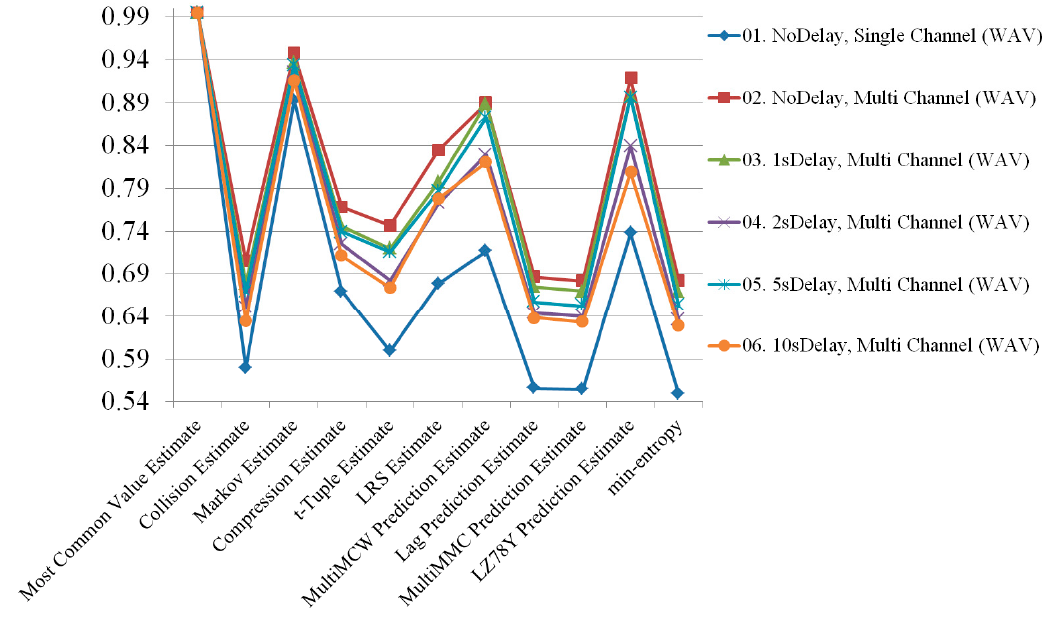
Figure 11. Randomness comparison results of the WAV file format generated from radio signals collected under all conditions.